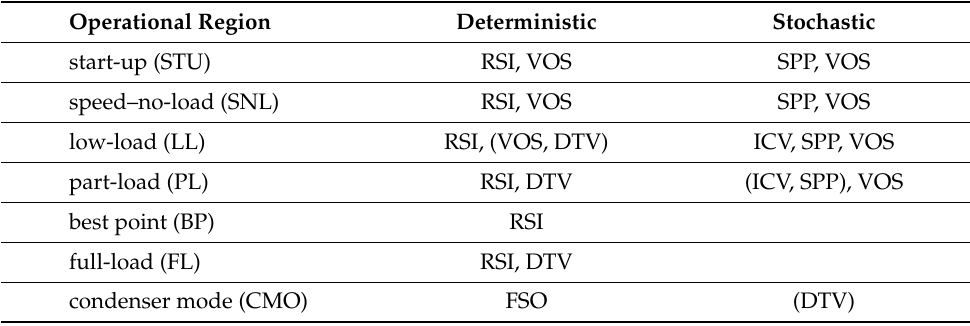
Table 2. Flow phenomena correlated to the operational region and resulting structure load (Phenom- ena in brackets could appear but not